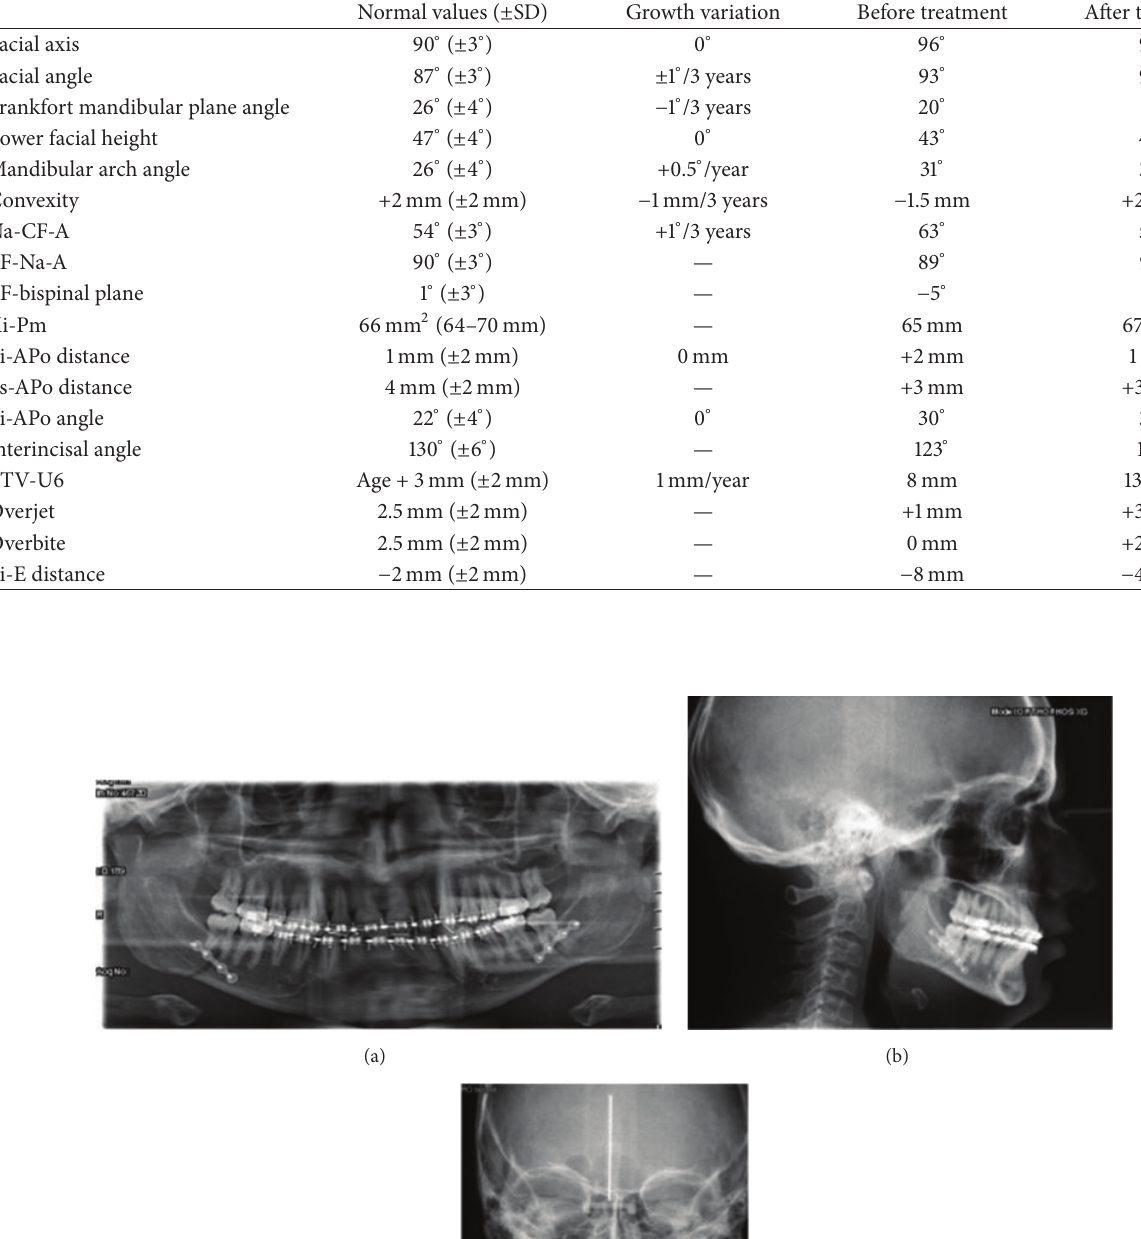
Table 1: Cephalometric analysis. Data before and at the end of the treatment. After a follow-up period of 6 years no variations were observed. Normal values ( ± SD) Growth variation Before treatment